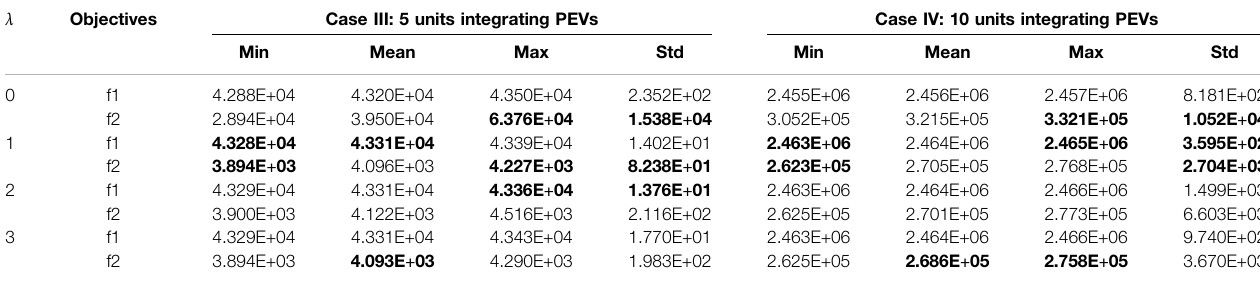
TABLE 12 | Statistics of 30 trials in Scenario B , units with disorderly PEVs, and Scenario C , units without orderly PEVs with different λ . λ Objectives